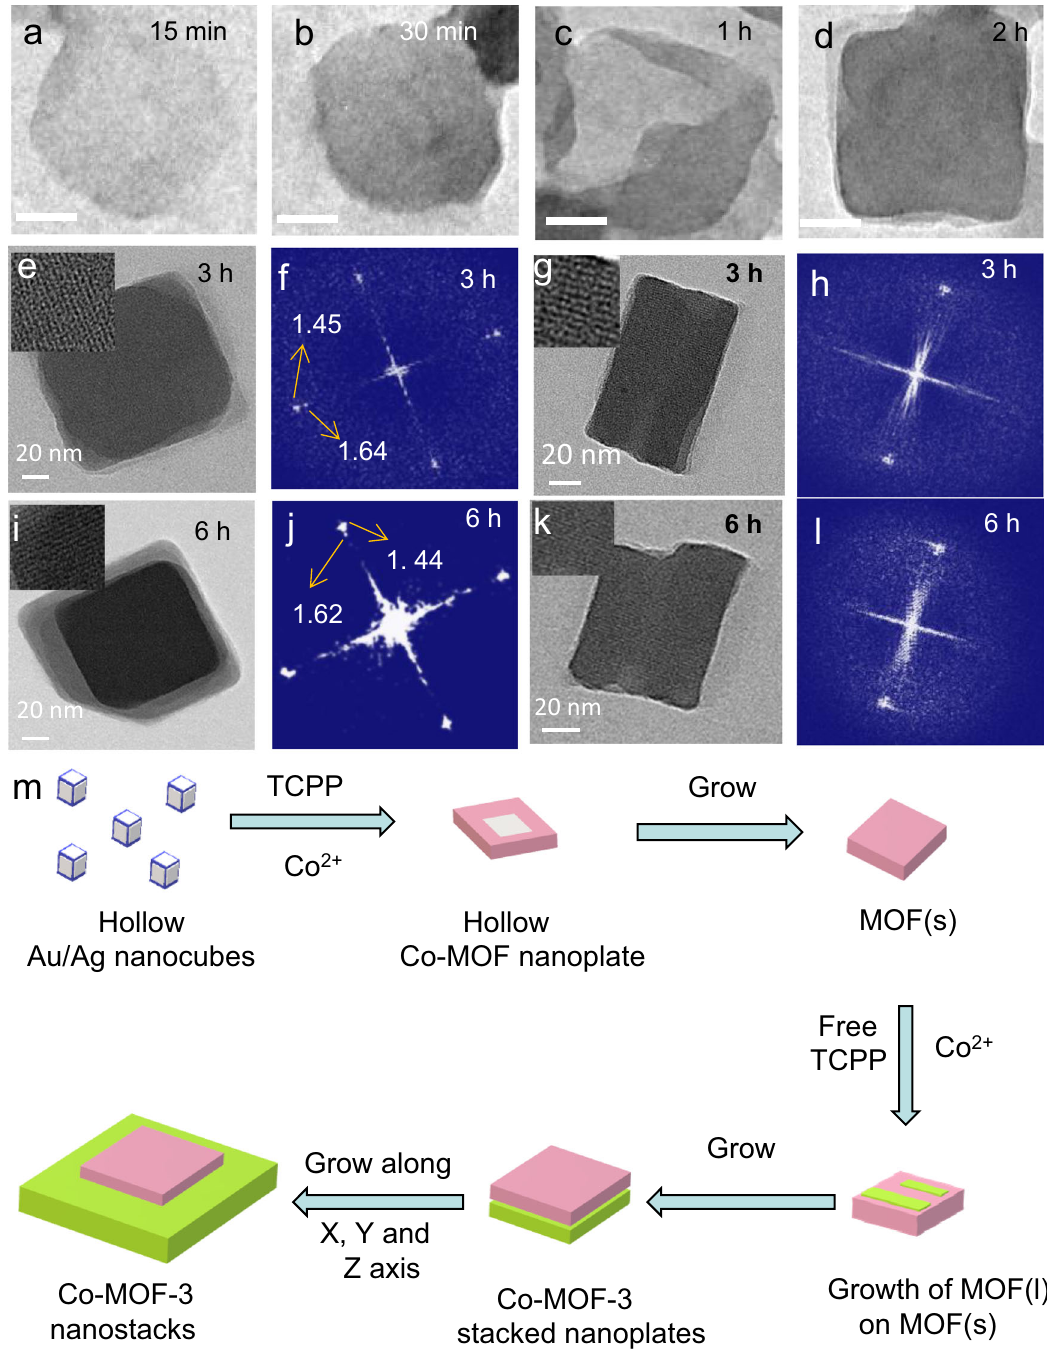
Fig. 4 Morphological evolution of Co-MOF-3 nanostacks in time. TEM images of Co-MOF-3 at various reaction time of 15 min ( a ), 30 min ( b ), 1 h ( c ), and 2 h ( d ) (bar is 50 nm). TEM and HE-TEM images of top ( e ) and side ( g ) Co-MOF-3 at 3-h reaction time, and the corresponding FFT images of f and h , respectively. Top ( i ) and side ( k ) TEM and HR-TEM images of Co-MOF-3 at 6 h and corresponding FFT images of j and l , respectively. m Schematic diagram of the formation mechanism of Co-MOF-3 nanostacks directed by the hollow Au/Ag highest transient photocurrent (Supplementary Fig. 52), and most signi fi cant amplitude of open circuit potential (OCP) values (Supplementary Fig. 53) under irradiation among the three Co- MOFs, further supporting the most ef fi cient photoinduced electron-hole transport and separation of Co-MOF-3 nanostacks due to the structural homojunction.